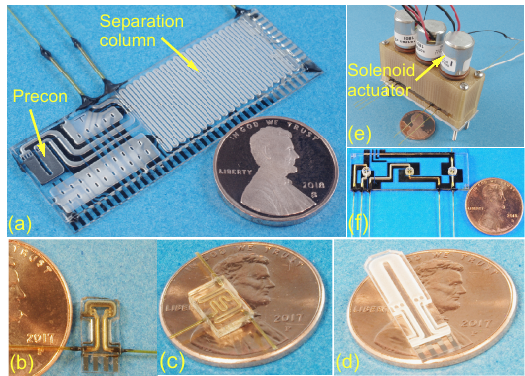
Figure 3. Microfabricated components within the PCA3mv: ( a ) monolithic chip, ( b ) preconcentrator, ( c ) T-connector, ( d ) carrier gas filter ( e ) Valve Module C1, and ( f ) valve module